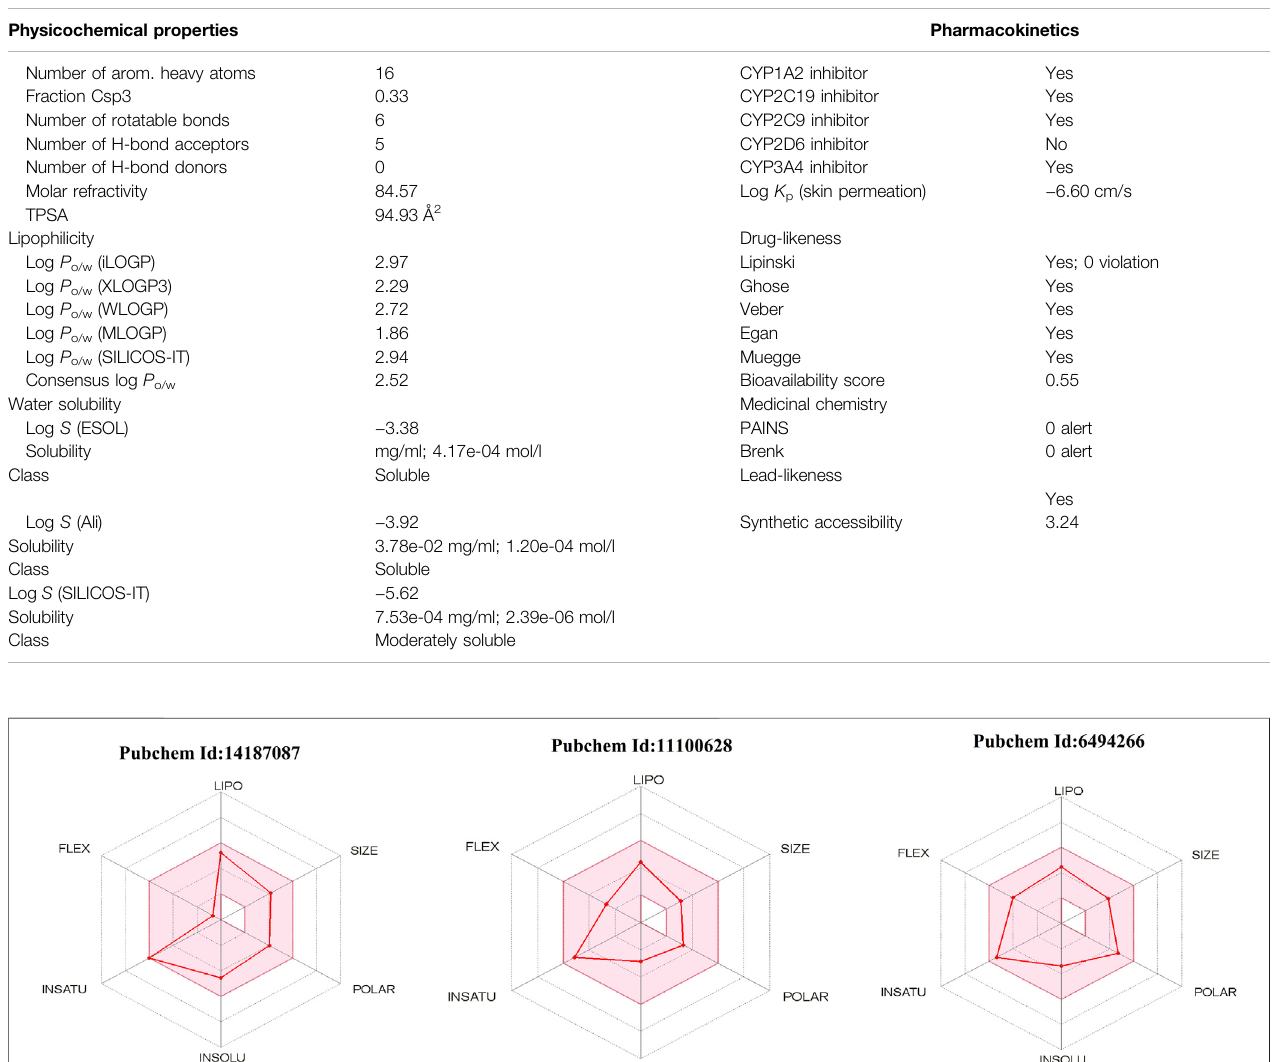
TABLE 3 | ( Continued ) Overview of different physicochemical properties, pharmacokinetics, medicinal chemistry, and drug-likeness of the compounds.